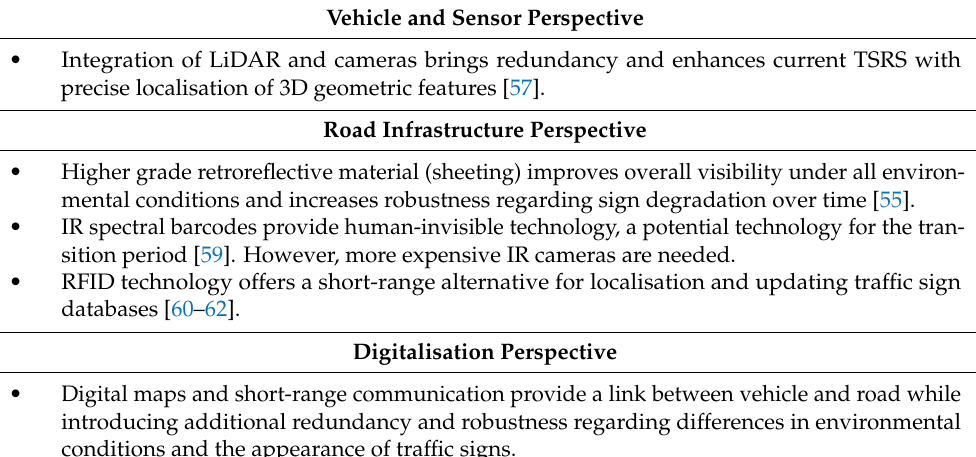
Table 6. Advances in traffic sign recognition-based